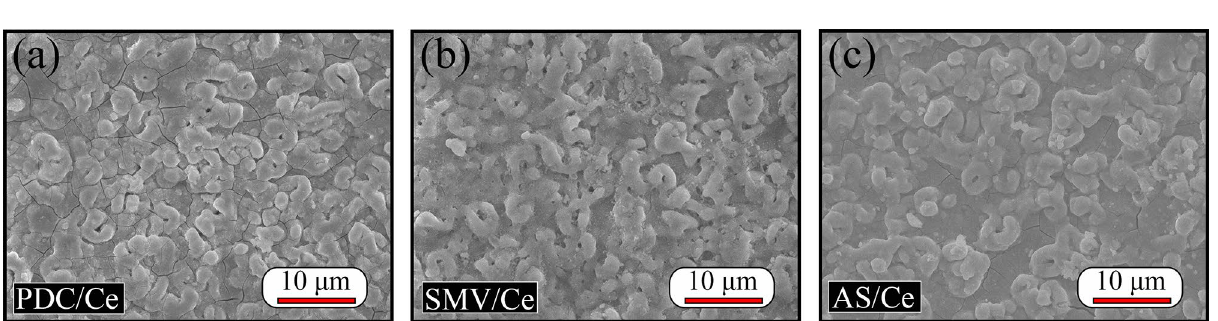
Figure 5. Bode EIS plots of PDC, SMV and AS specimens after ( a ) 20 min, ( b ) 1 h and ( c ) 3 h immersion in 3.5 wt% NaCl solution.